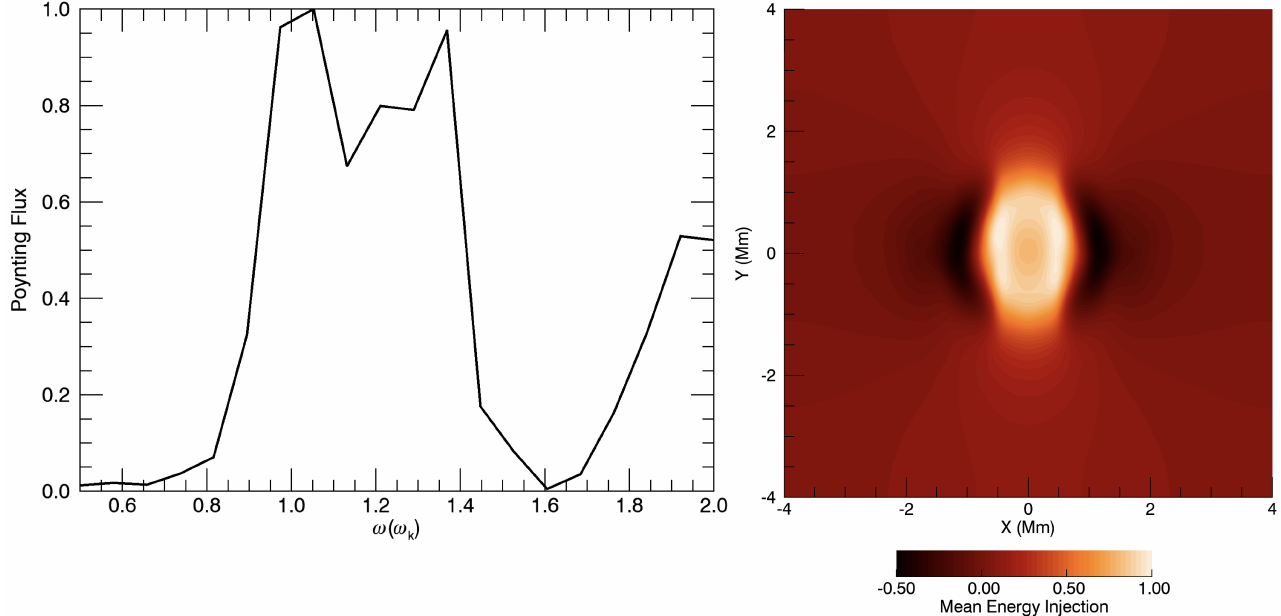
Figure 9. Left : injected Poynting flux associated with each component of the velocity driving over the duration of the BbUni simulation. The curve is normalised to its maximum. Right : spatial distribution of the mean Poynting flux in the BbUni simulation at each point on the driven boundary ( z = 0 Mm). See text for